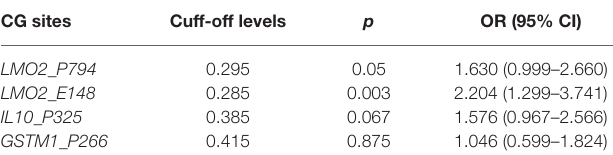
TABLE 2 | Prediction of asthma by cutting off CG site methylation levels of LMO2 , GSTM1 , and IL10 according to the ROC curve followed by DeLong